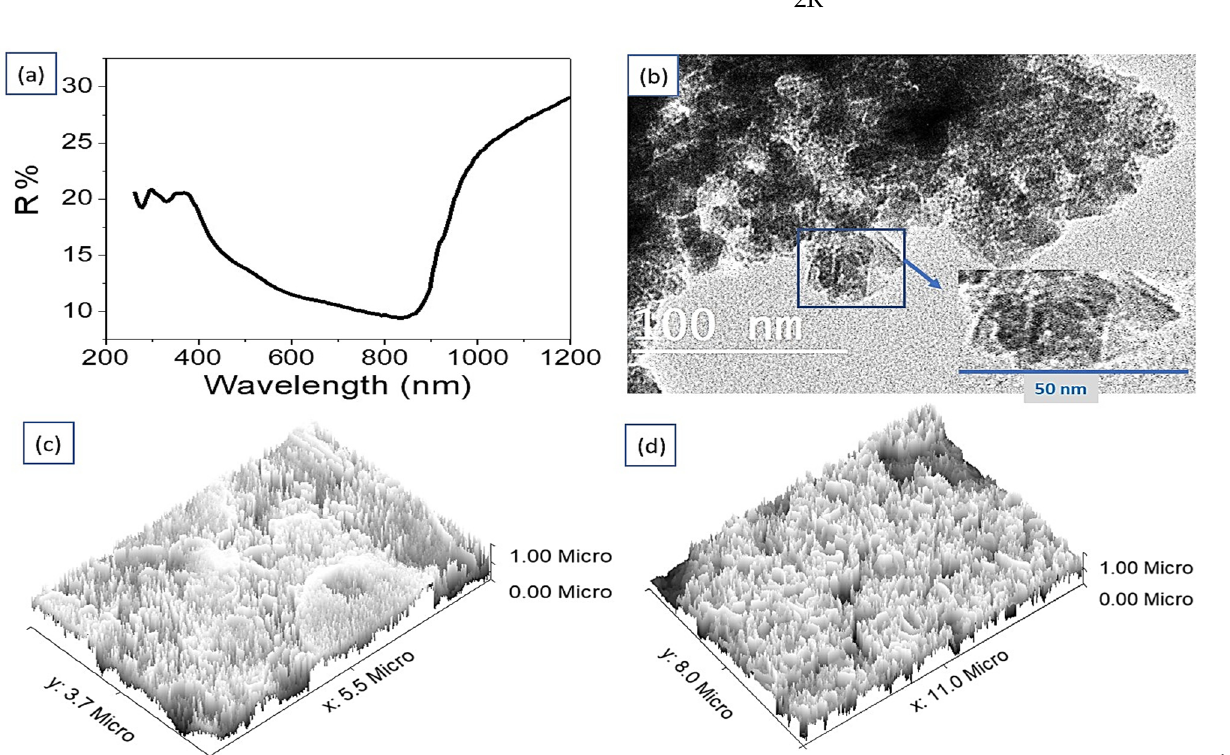
Figure 2. ( a ) The optical reflectance and ( b ) TEM of CuFeO 2 . ImageJ theoretical of ( c ) CuO and ( d ) CuFeO 2 nanoparticles.